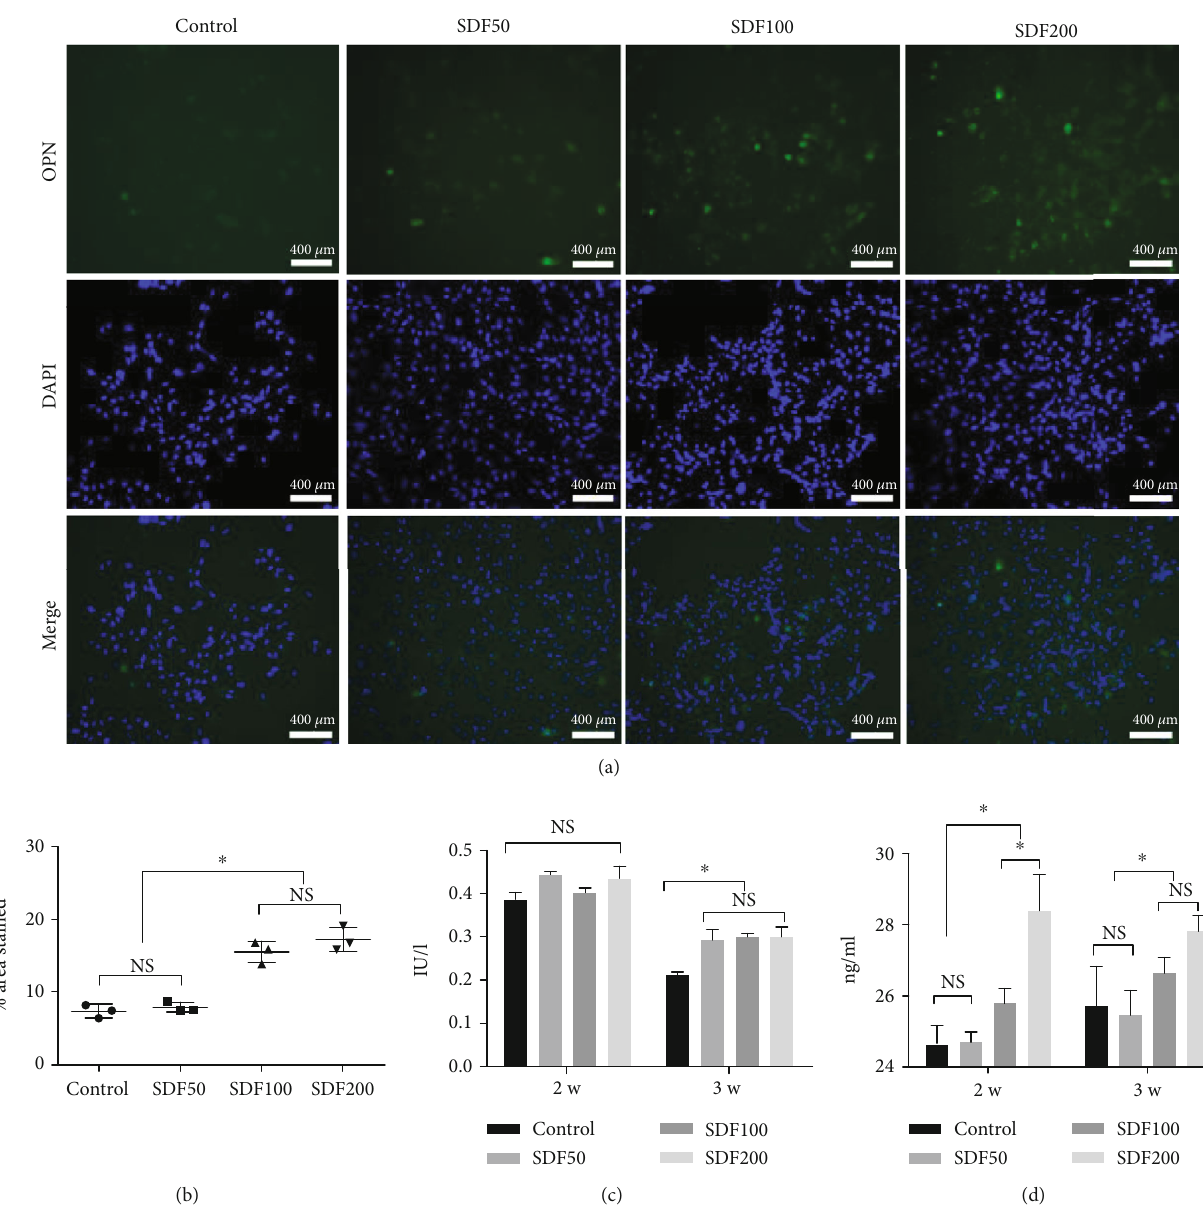
Figure 6: Osteogenic di ff erentiation assays of MSCs after 14 and 21 days of culture on the four groups of SDF-1 α /OPF/BP composites. (a) OPN immuno fl uorescence staining on the 21 st day of osteogenic di ff erentiation. (b) The percentage of OPN-positive areas of the SDF200 and SDF100 groups was signi fi cantly higher ( ∗ p < 0 : 05 ) than that of the SDF50 and control groups. (c) ALP assay showed that ALP expression levels of the four groups were similar at day 14, while the expression levels in the control group were signi fi cantly lower ( ∗ p < 0 : 05 ) than those of the other three groups on the 21 st day. (d) OCN assay showed that the OCN expression levels in the SDF200 and SDF100 groups were signi fi cantly higher ( ∗ p < 0 : 05 ) than those of the SDF50 and control groups on both days 14 and